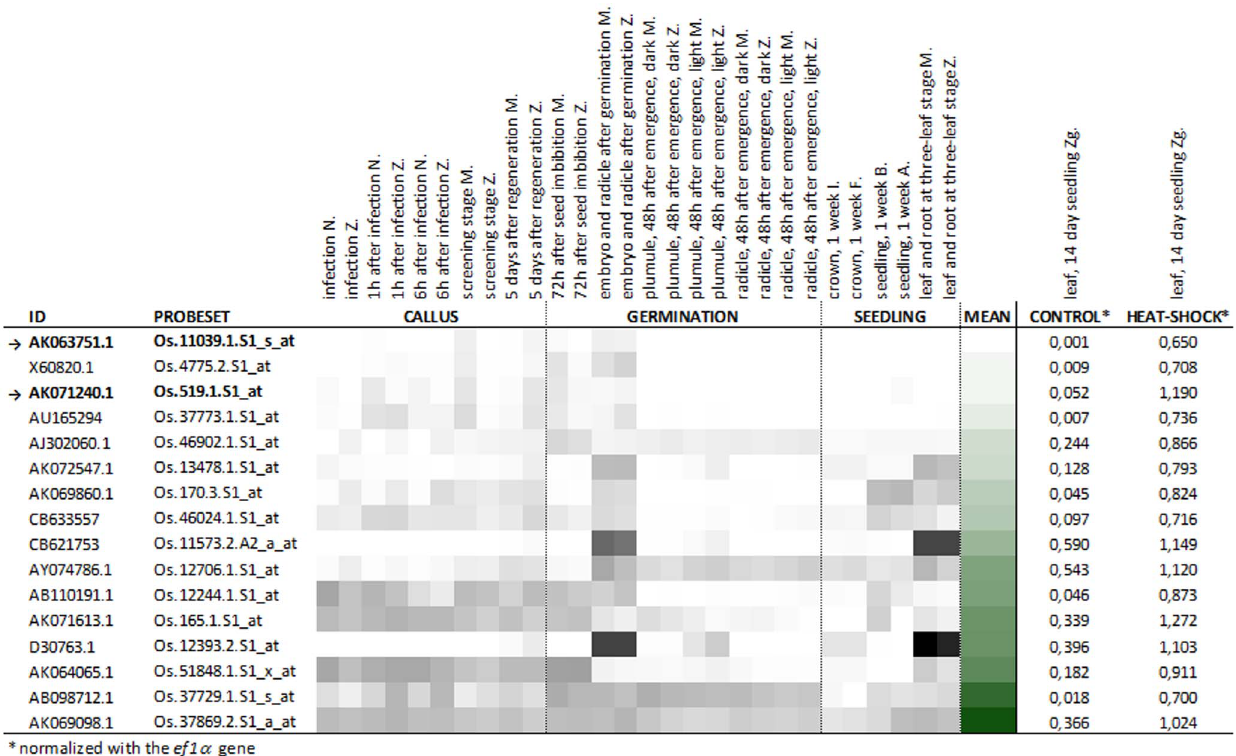
Figure 1. A summary of the expression profiles of a selection of sequences induced by high temperature, in callus and seedlings of eight rice genotypes [Bala (B), FL478 (F), IR29 (I), Minghui 63 (M), Zhenshan 97 (Z), indica subspecies, and Azucena (A), Nipponbare (N) and ZhongHua 11 (Zg), japonica subspecies], from published insilico data. Cluster analysis of 16 genes with the highest expression or induction in response to heat-shock, in a total of 14 tissues considered relevant to the process of obtaining transgenic plants (grey scale). The overall mRNA levels in these tissues and developmental stages were estimated using the mean expression values (green scale). Dark to light color scale represents high to low expression levels, the darkest color corresponding to 90162 (grey scale) and 19788 (green scale) normalized fluorescence units. Arrows indicate the two sequences whose promoters were selected to produce transgenic plants. doi:10.1371/journal.pone.0109990.g001 respectively, were PCR amplified from rice var. Senia genomic fragments, pHsp18 and pHsp82, were cloned and sequence DNA. Their 3 9 end was at position 2 1 relative to the ATG verified. The activity of these promoter fragments was experi- translation start codon. Os.hsp18 and Os.hsp82 promoter mentally assessed using the Discosoma spp. red fluorescent reporter